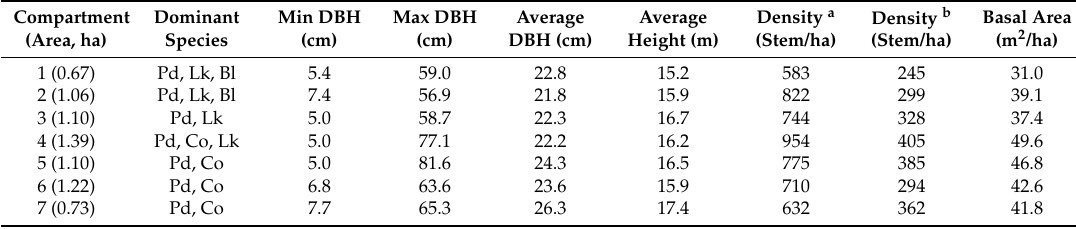
Table 1. Characteristics of the forests at the study site surveyed from April 2005 to June 2007. DBH, diameter at breast height. Pd, Pinus densiflora ; Co, Chamaecyparis obtusa ; Lk, Larix kaempferi ; Bl, broadleaved trees. a stem density of the trees with a DBH larger than 5 cm; b stem density of the trees with a DBH larger than 25 cm (the upper